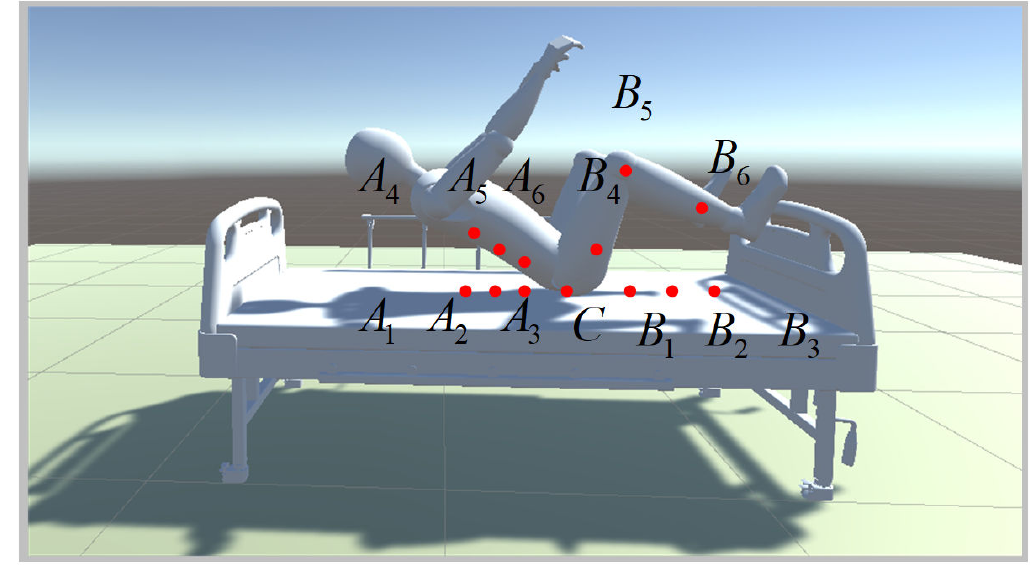
Figure 9. Diagram of Barrier